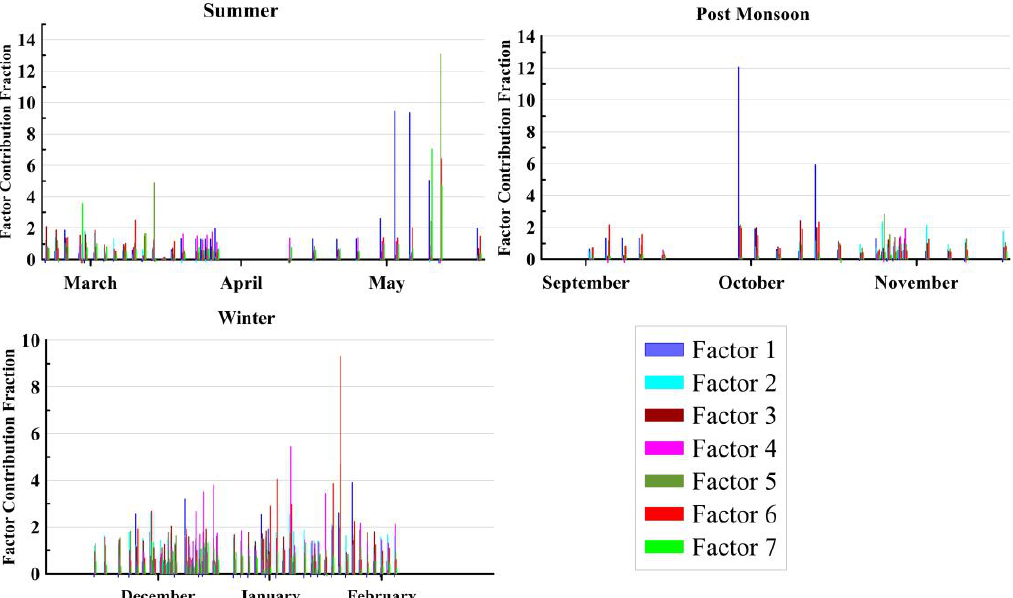
Figure 9. Seasonal variation of factor profile of aerosol species and their fractional contribution in different aerosol samples. Major dominant factors are factors 1, 2 and 3, which have been identified as sulfate-rich, sea salt and dust-dominated, respectively (see text for details).